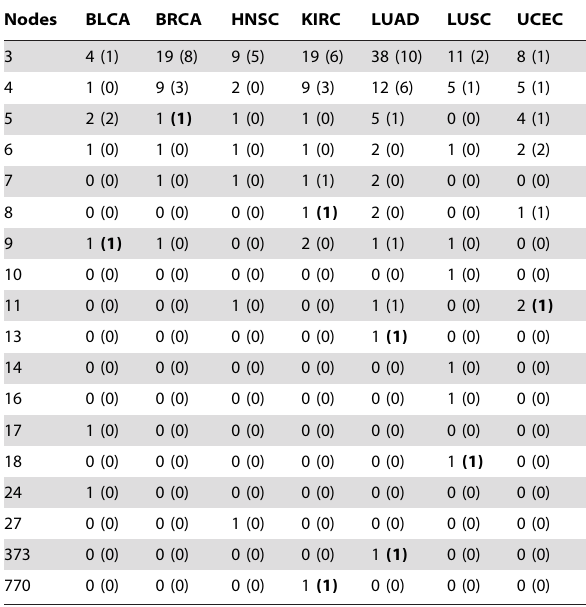
Table 3. Number of significant subnetworks, modules and